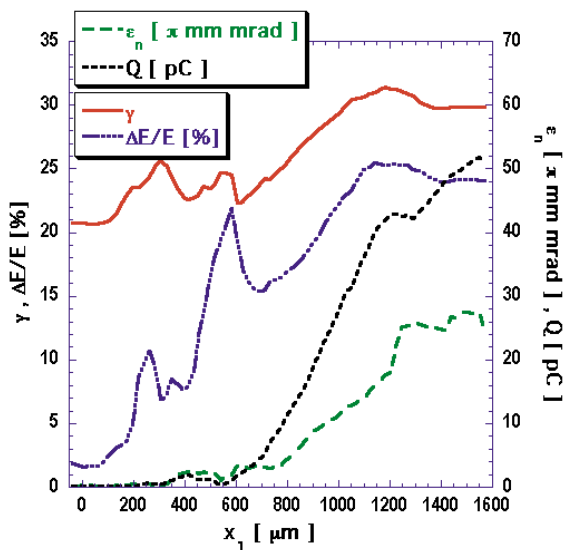
FIG. 9. (Color) The evolution of some important electron beam characteristics from the time after exiting the first gas jet until after exiting the second gas jet. The data are for a second gas jet with w 2 (cid:1) 1.5 mm, L g 2 (cid:1) 0.5 mm, and n p 2 (cid:1) 1.0 3 10 18 cm 2 3 . The beam energy g , the relative energy spread D E (cid:3) E , the normalized emittance e n , and the beam charge Q are shown. Only electrons with p 1 $ 20 mc were included in the calculation of the numbers shown in the